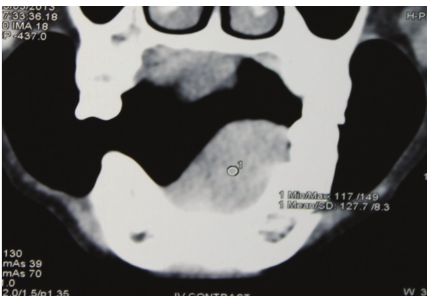
Figure 3: Axial CT shows lingual nerve (small circle) found within the mass in the left floor of the mouth.